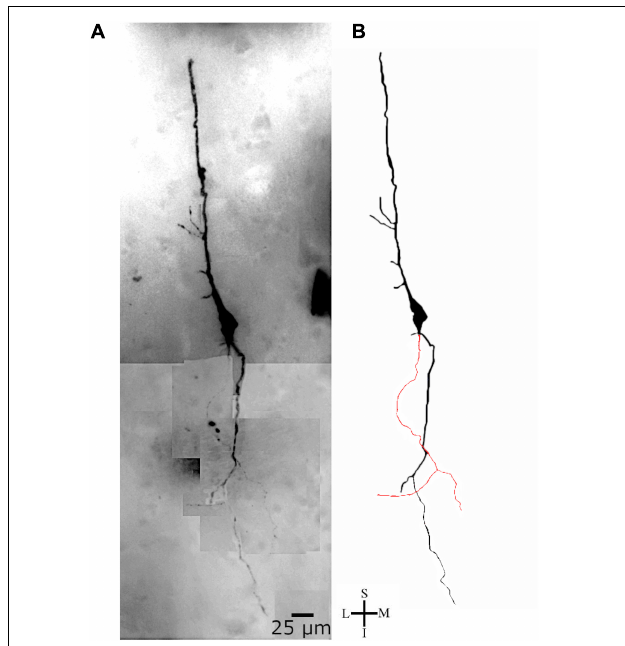
FIGURE 10 | (A) Photomicrographic composition of a Golgi-impregnated spindle-shaped neuron from layer V in the transition to layer VI in the human precuneus (central region, 61.1 mm posterior to the midpoint of the anterior commissure) observed using brightfield microscopy. (B) Two-dimensional image reconstruction of the same neuron in (A) (pial surface at the top). Note the cell body shape, two main ascending and descending primary dendrites with various branching points, and the presence of a delicate axon (colored in red) emerging from the soma, close to the descending dendrite, and ramifying at approximate right angles. Image reconstructed using the Neuromantic software (University of Reading, United Kingdom) with adjustment of contrast made with Photoshop CS3 (Adobe Systems, Inc., United States). Coordinates in (A,B) : I, inferior; L, lateral; M, medial; S, superior. Scale = 25 µ